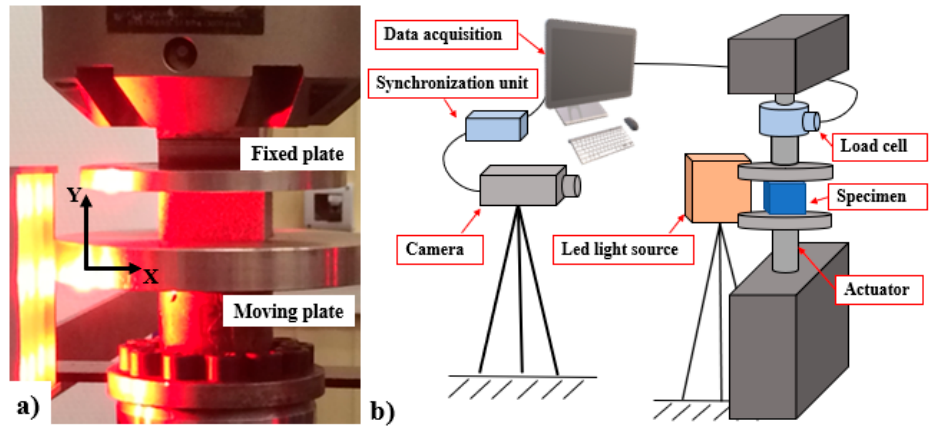
Figure 2. ( a ) Cyclic compression test apparatus. ( b ) Schematic of the DIC set-up.